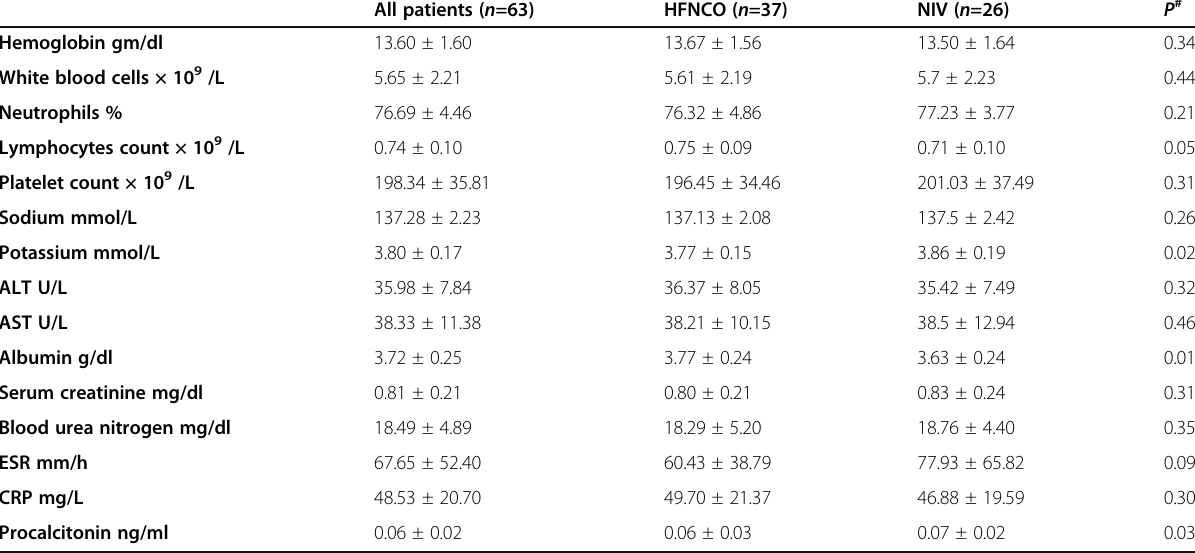
Table 2 Laboratory tests results of the studied patients